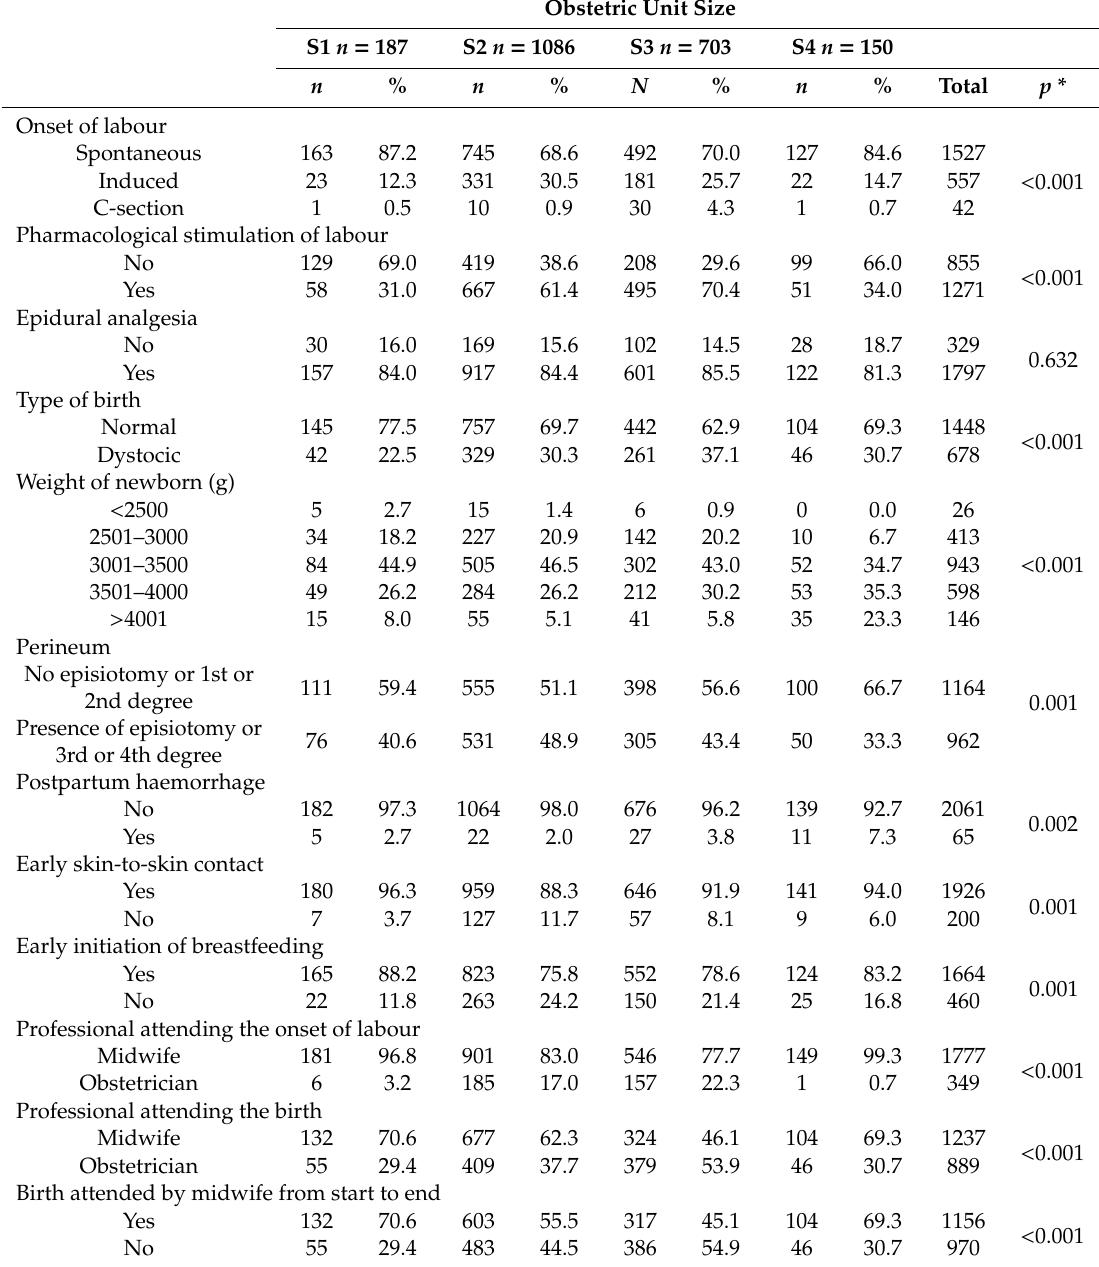
Table 1. Characteristics of the sample, by obstetric unit size ( N =